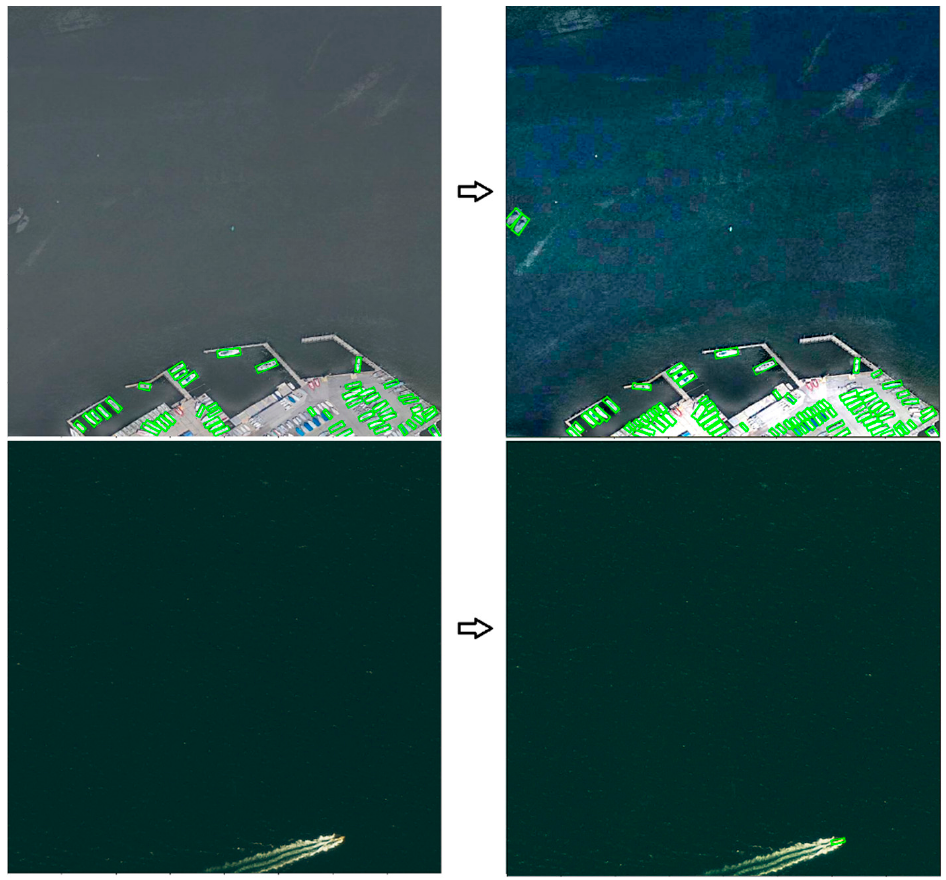
Figure 13. Display of test results before and after model improvement—small target missed detection improvement.